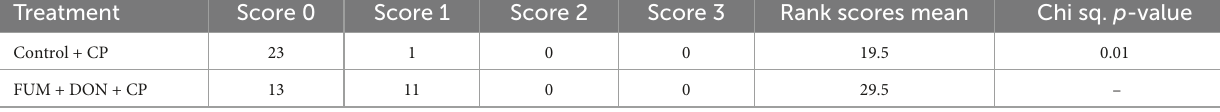
TABLE 2 Effect of subclinical fumonisins (FUM) and deoxynivalenol (DON) contamination on necrotic enteritis lesion scores.